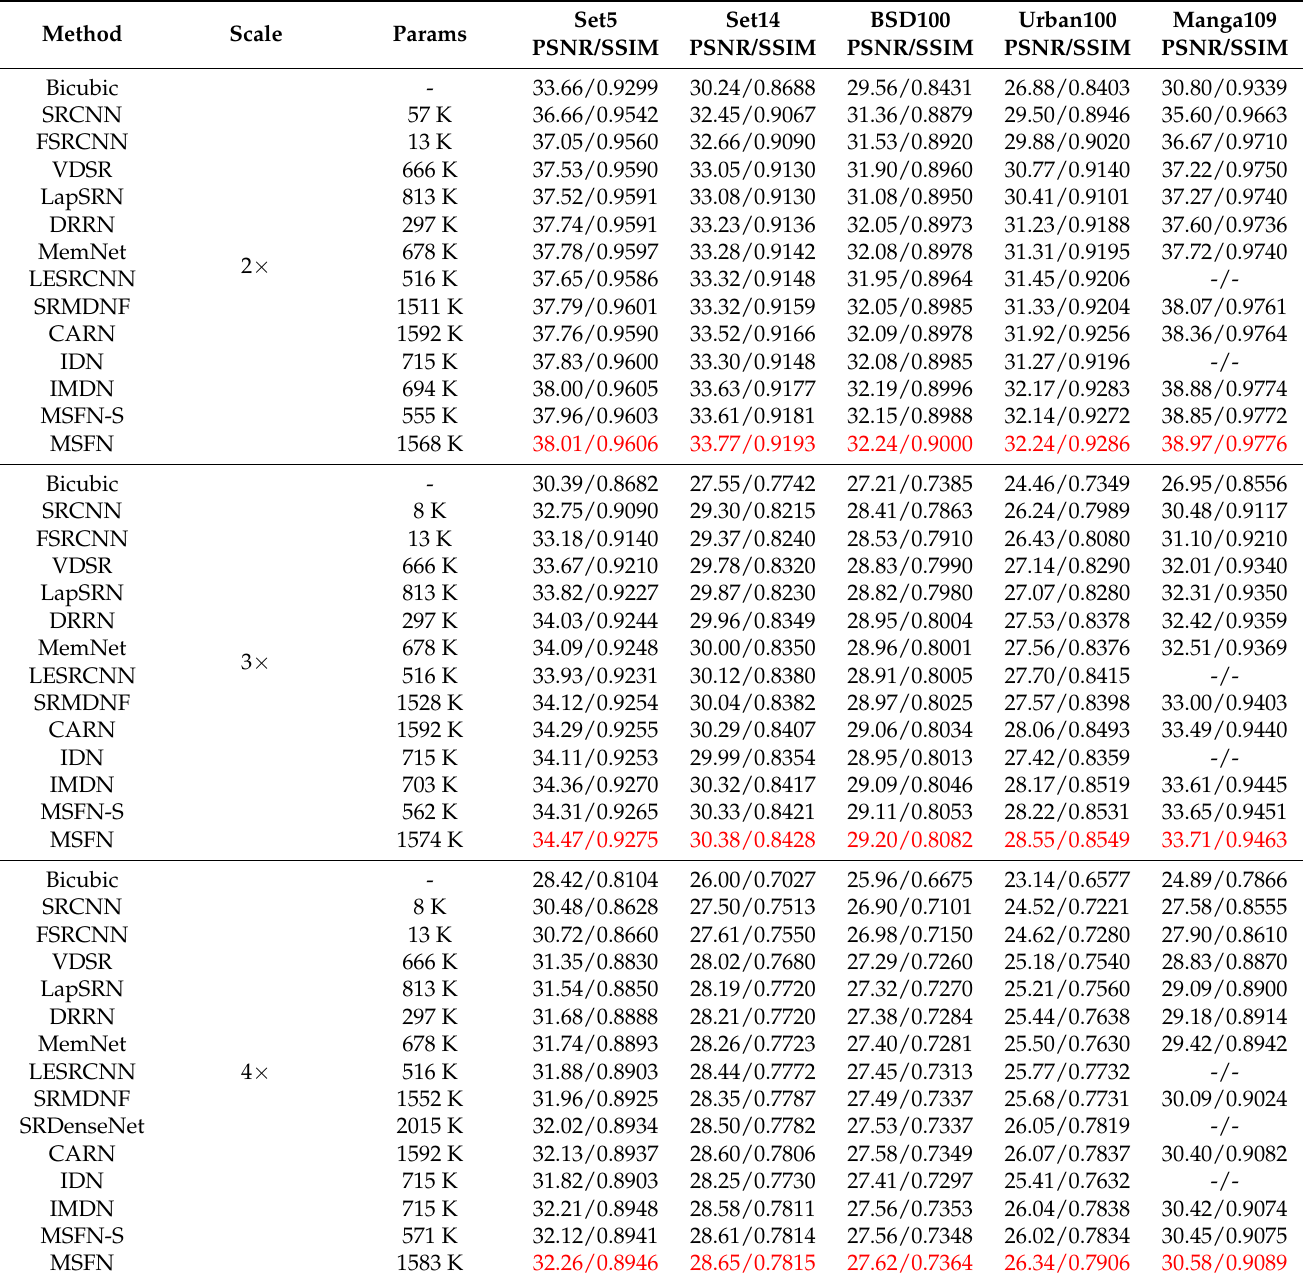
Table 3. Average PSNR/SSIM value for scale factor × 2, × 3, and × 4 on datasets Set5, Set14, BSD100, Urban100, and